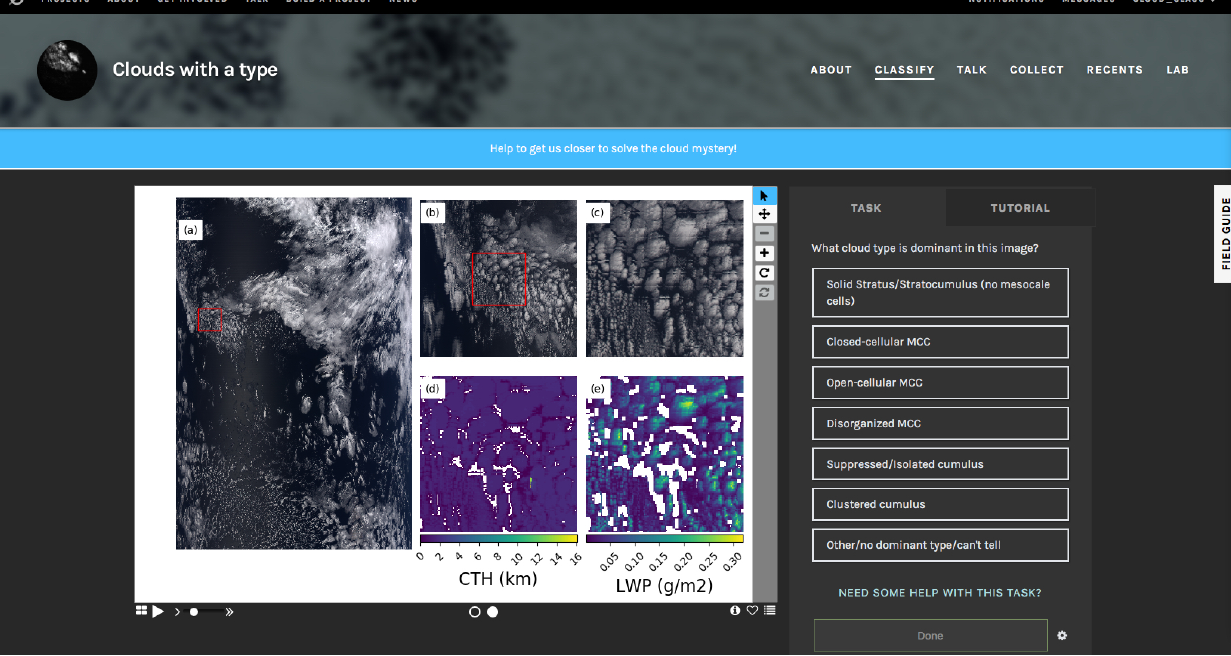
Figure 2. The Zooniverse interface for manual labeling. The center image is made up of five panels. Panel (a) shows the full granule (usually 2030 × 1350 pixels) true-color image for a large context. Panel (b) shows a portion of the granule immediately surrounding the scene to be labeled, outlined by the red square. Panel (c) shows the visible scene image while panels (d, e) show the cloud top height and liquid water path fields in the scene to be labeled. The panels to the right of the center image show labeling choices. The tutorial document is available by clicking on the “FIELD GUIDE” tab on the right side. Additional options for scenes with heavily mixed types, scenes with sea ice, or scenes with other issues are found in the “other” menu. The image is a screenshot of our Zooniverse project.